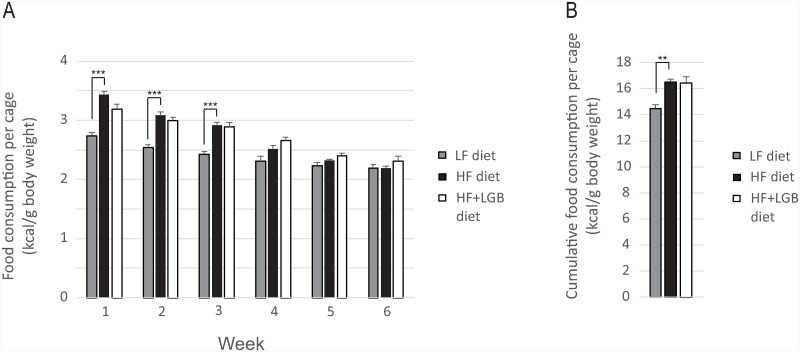
Food consumption during the study.Fig 3A shows the weekly and Fig 3B the cumulative food consumption during the six weeks’ study. Animals received low-fat diet (LF diet, 10% energy from fat, grey columns), high-fat diet (HF diet, 46% energy from fat, black columns) or high-fat diet supplemented with lingonberry (HF + LGB diet, white columns). Food consumption was measured once a week. The results are expressed as kcal/body weight in grams. Values represent mean + SEM, n = 10 mice per group; as the mice were housed two mice per cage, n = 5 was used in the statistical calculations. Repeated measures two-way ANOVA (Fig 3A) and one-way ANOVA (Fig 3B) with Bonferroni post-test was used in the statistical analysis. Differences between the groups are marked with **p<0.01 and ***p < 0.001.